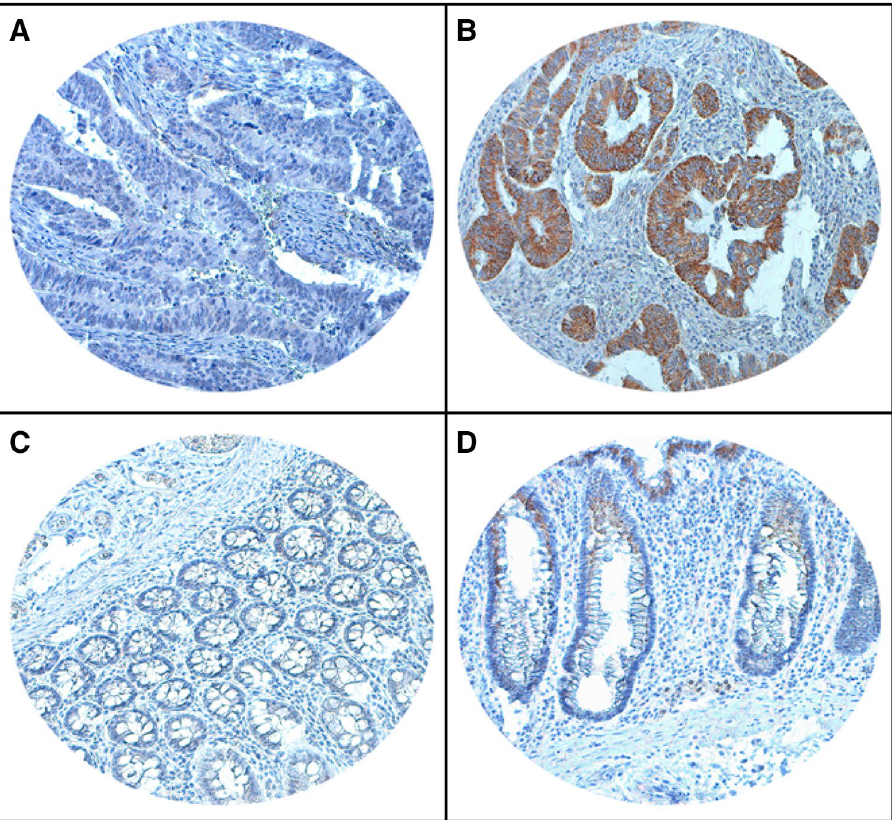
Figure 1. Immunohistochemical analysis of ZNF677 expression in colorectal carcinoma (CRC). Representative examples of tumors showing ( A ) loss of expression and ( B ) positive expression of ZNF677 in CRC tissues. Representative examples of normal colonic tissues showing ( C ) loss of expression and ( D ) positive expression of ZNF677. (20×/0.70 objective on an Olympus BX 51 microscope (Olympus America Inc, Center Valley, PA,